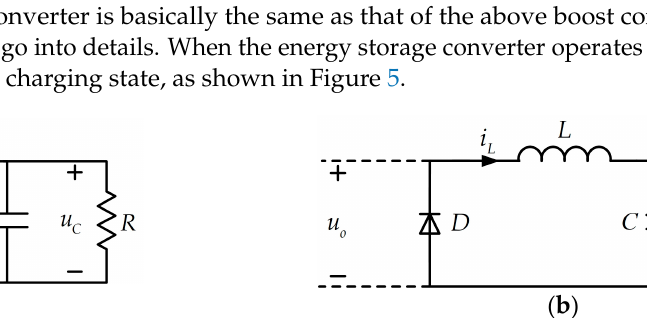
Figure 5. Equivalent circuit schematic of buck circuit in two working modes. ( a ) Equivalent circuit when the switch is off in the buck circuit; ( b ) Equivalent circuit when the switch is on in the buck circuit.